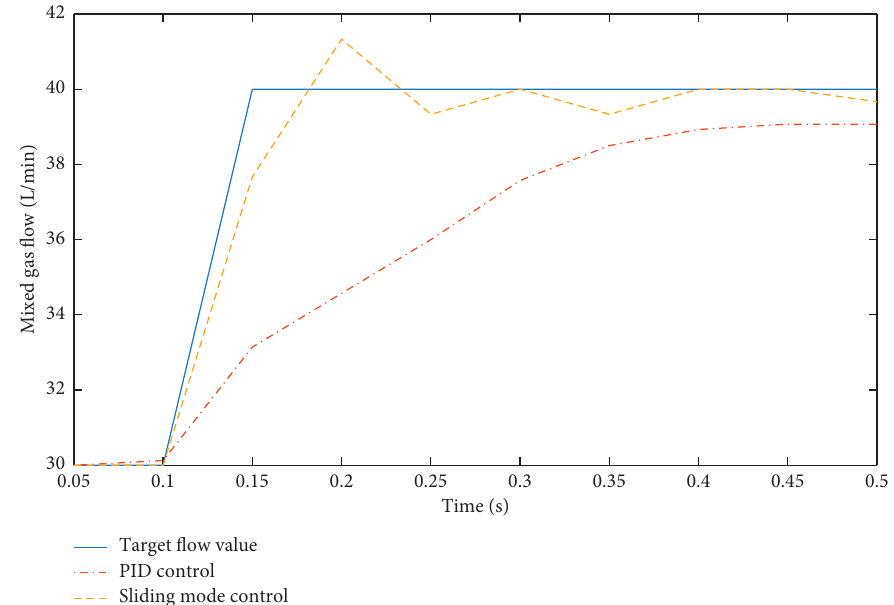
Figure 6: Comparison of actual flow output under the total flow regulation range of